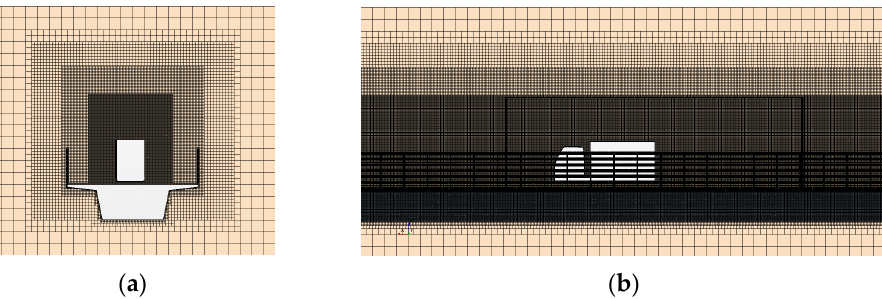
Figure 4. The mesh rendering of a vehicle on the bridge (( a ) Front view of the domain; ( b ) side view of the